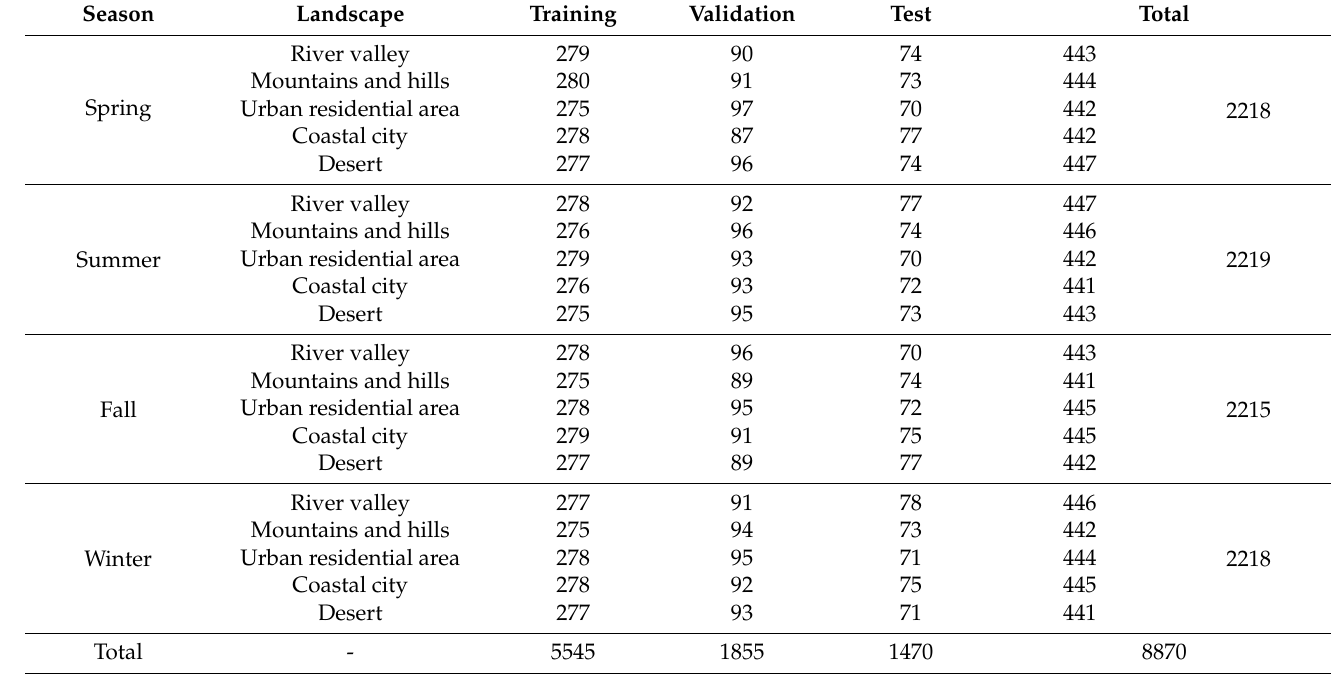
Table 1. Number of different types of images selected in our